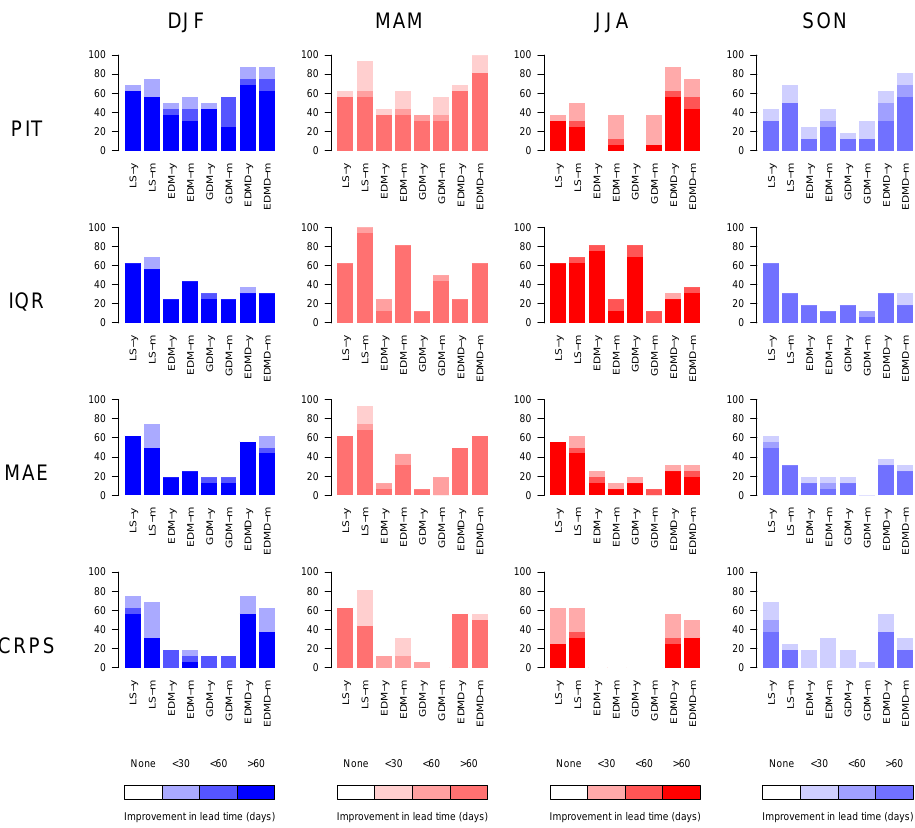
Figure 8. Fraction of catchments (%) in each UFL value category, i.e. fraction of catchments in which bias corrections increase the lead time up to which seasonal streamflow forecasts have skill with respect to seasonal streamflow forecasts generated from raw seasonal precipitation forecasts. Each row corresponds to an evaluation criterion and each column corresponds to a season. Colour shades indicate the UFL category, i.e. the lead time up to which streamflow forecasts are